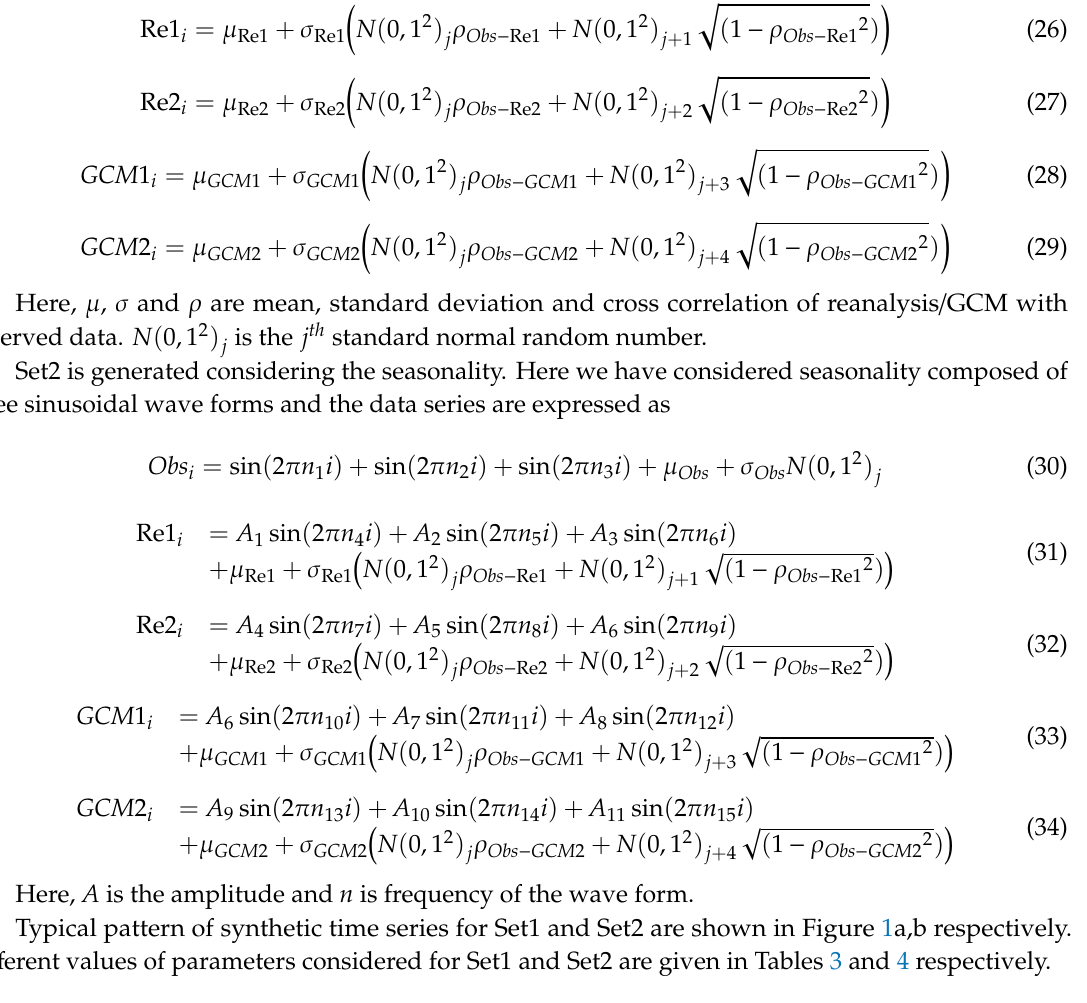
Table 3. Parameters of series for